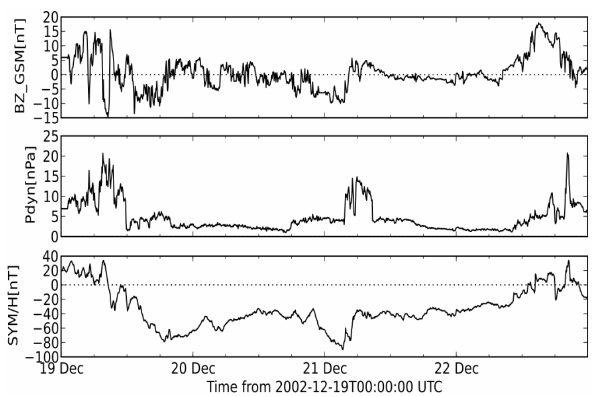
Fig. 2. The solar wind interplanetary and geomagnetospheric con- ditions from 19 December to 22 December